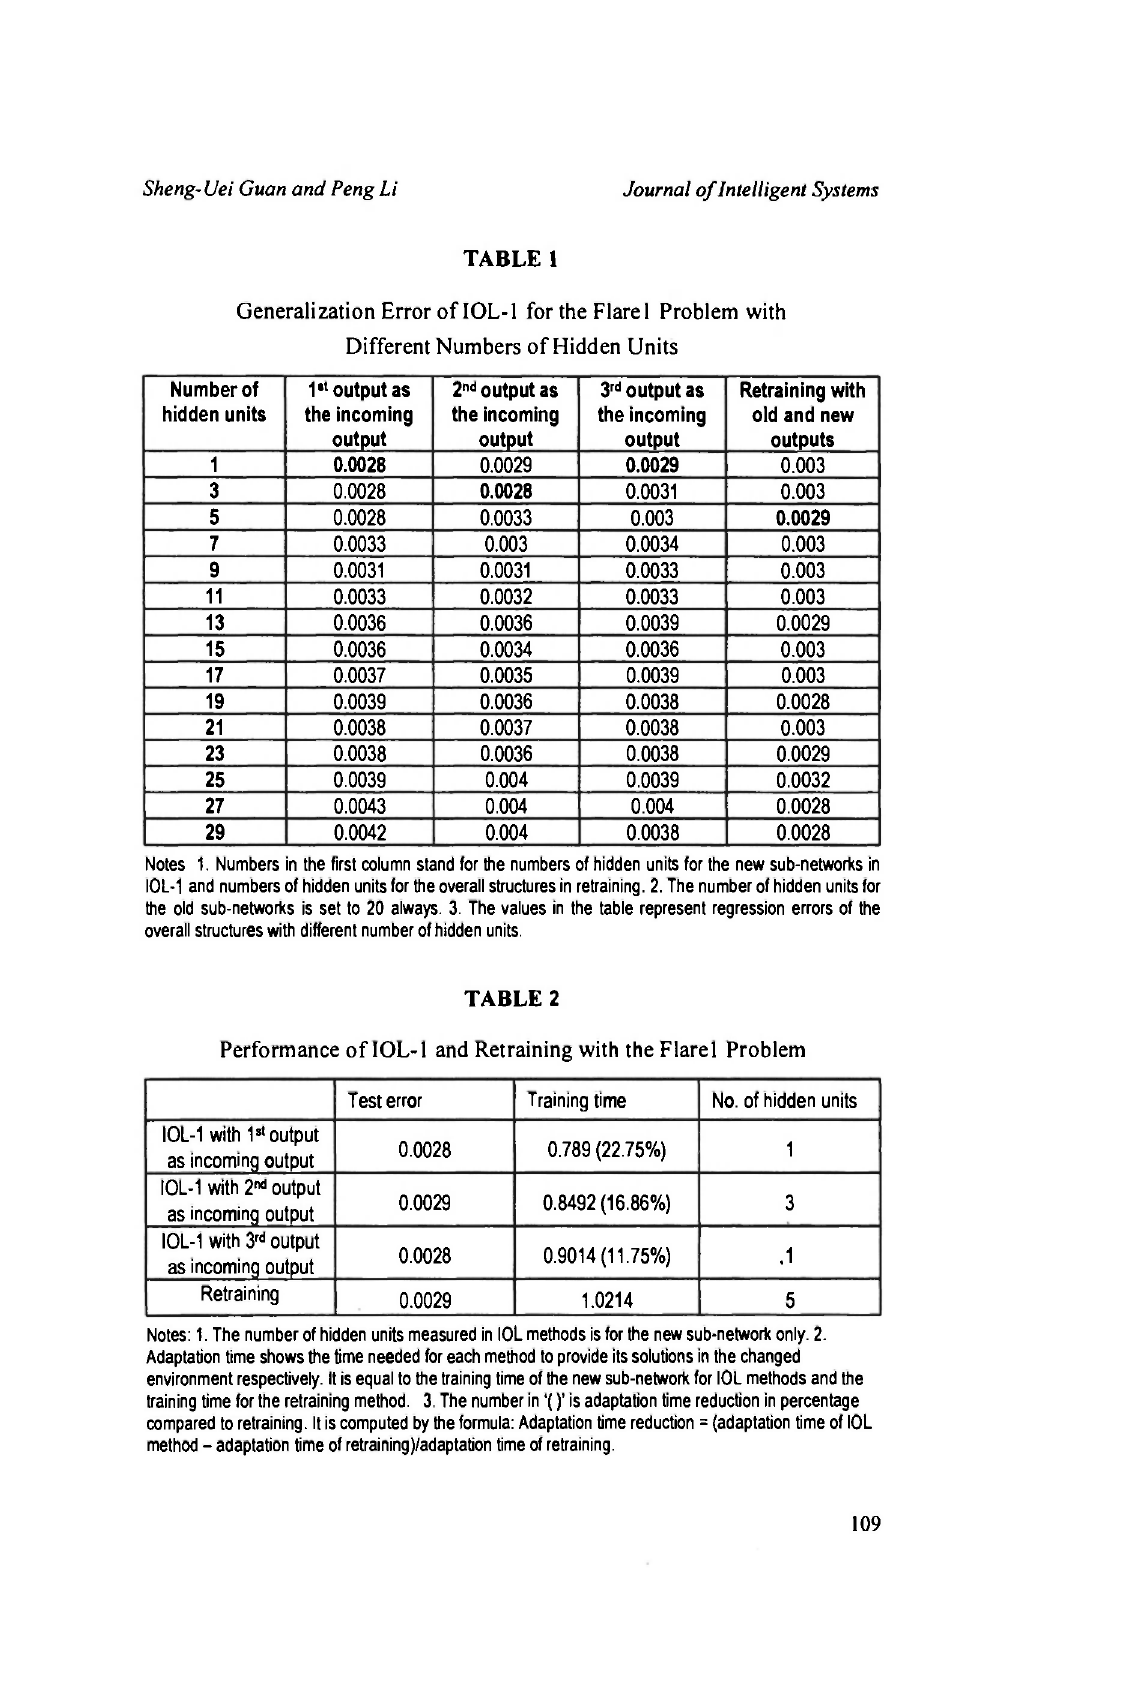
Generalization Error of IOL-1 fortheFlarel Problem